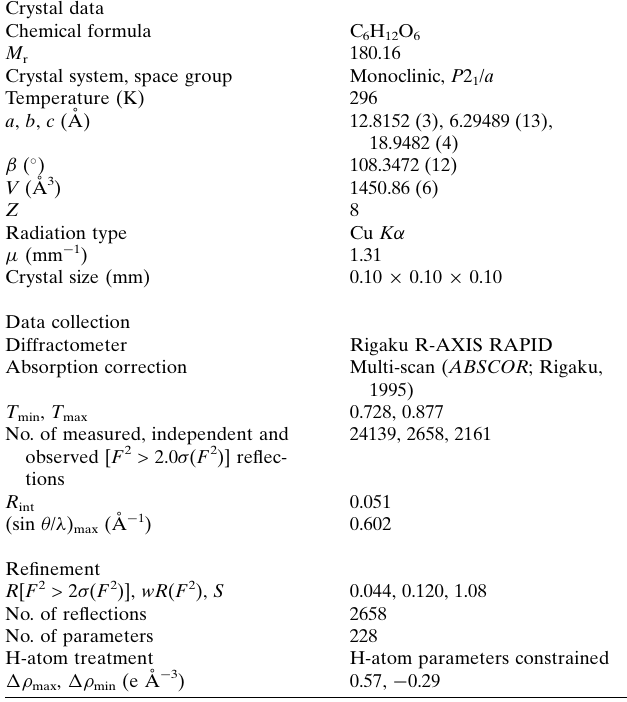
Table 2 Experimental details. Crystal data Chemical formula